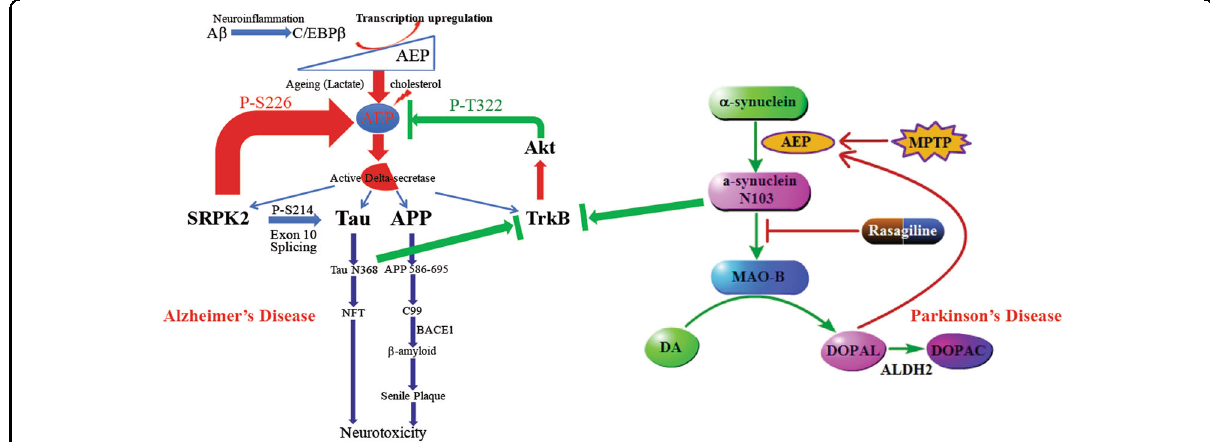
Fig. 3 Active δ -secretase is the trigger for both AD and PD. Schematic model of the C/EBP β /AEP pathway mediating AD pathology. δ -Secretase cleaves numerous substrates, including SRPK2, APP, Tau, and TrkB receptors. SRPK2 phosphorylates δ -secretase on the S226 residue and activates its protease activities. BDNF/TrkB signaling inhibits δ -secretase via Akt phosphorylation on T322, promoting neuronal survival (left panel). A schematic model shows the role δ -secretase in α ‐ synuclein-induced PD pathology. δ -Secretase ‐ cleaved α -synuclein N103 triggers MAO ‐ B activation that feeds forward to further activate δ -secretase by the DA metabolite DOPAL (right